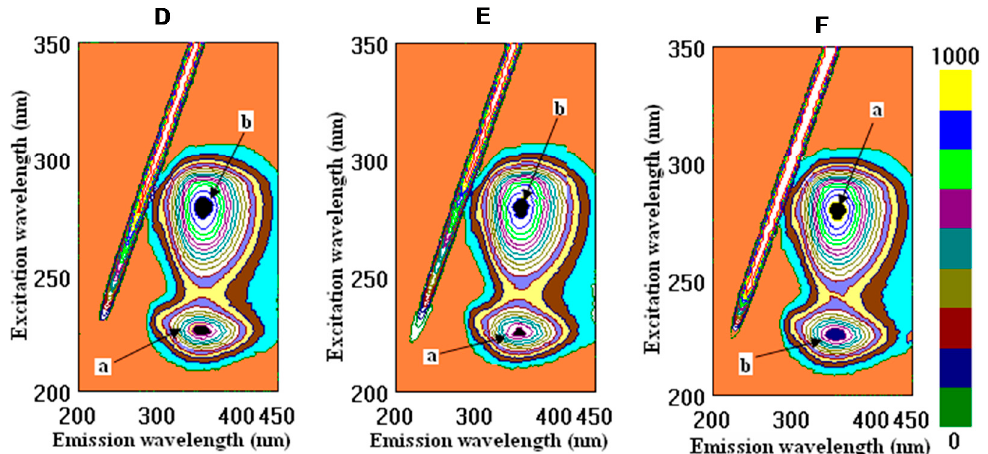
Figure 2. Fluorometric measurements in a three-dimensional fluorescence analysis (3D-FL) of red wine samples and standards after interactions with human serum albumin (HSA). Cross-images of the results obtained from the 3D-FL of the investigated samples after their interaction with HSA are shown in the following order: ( A ) CSCarmel2; ( B ) CSYarden2; ( C ) tannic acid; ( D ) quercetin; ( E ) caffeic acid; ( F ) HSA in solution. Abbreviations: CSCarmel2, Cabernet Sauvignon Carmel Selected, vintage 2019; CSYarden2, Cabernet Sauvignon Golan Heights Winery Yarden, vintage 2019. The locations of peaks a and b are shown in the figure and in Table 2 (for interpretation of the references to color in this figure legend, the reader is referred to the web version of this article). Table 2. Spectral data of the investigated samples and some standards .